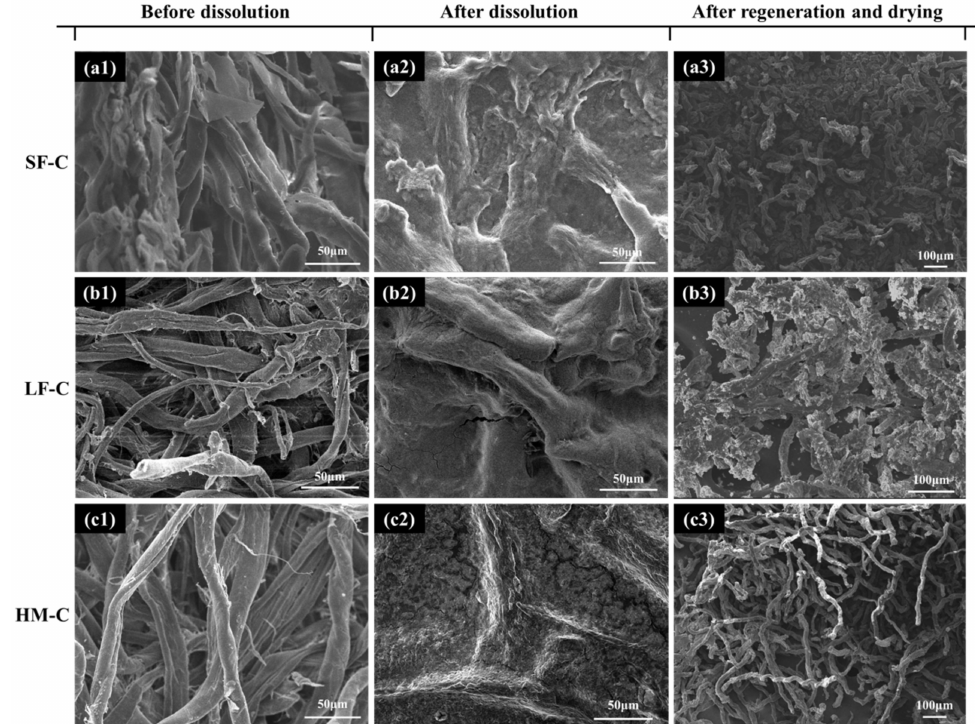
Figure 2. SEM images of ( a ) SF-C, ( b ) LF-P and ( c ) HM-C (a1, b1, c1) before dissolving the (a2, b2, c2) as-prepared cellulose solution under strong stir and (a3, b3, c3) the regenerated cellulose particles after the evaporation of water.